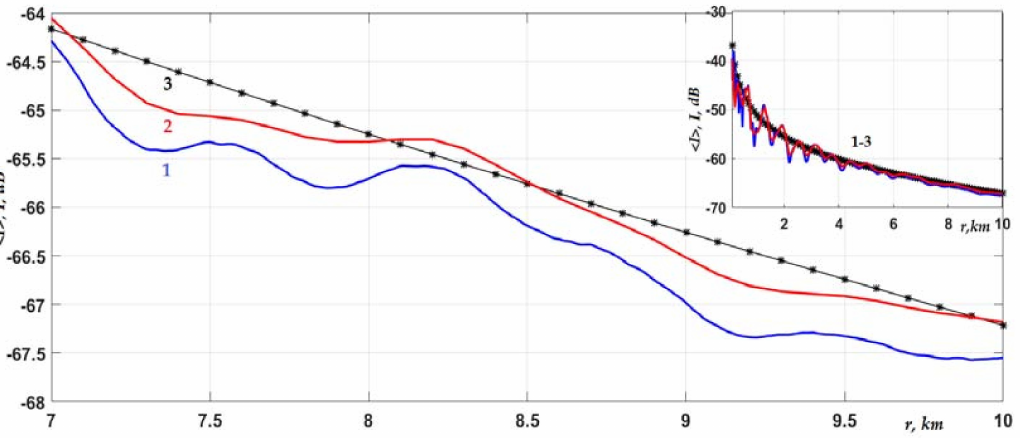
Figure 7. (cid:104) I (cid:105) in the range r = 7–10 km in a random waveguide with bathymetry fluctuations, f = 500 Hz. (cid:104) c 1 (cid:105) = 1500 m/s, δ c 1 = 0. z = z 0 = 24 m. Curves: 1 is OW solution, L h = 100 m; 2 is OW solution, L h = 1 km; 3 (markers)— I in the unperturbed waveguide ( δ h = 0), averaged over the interference